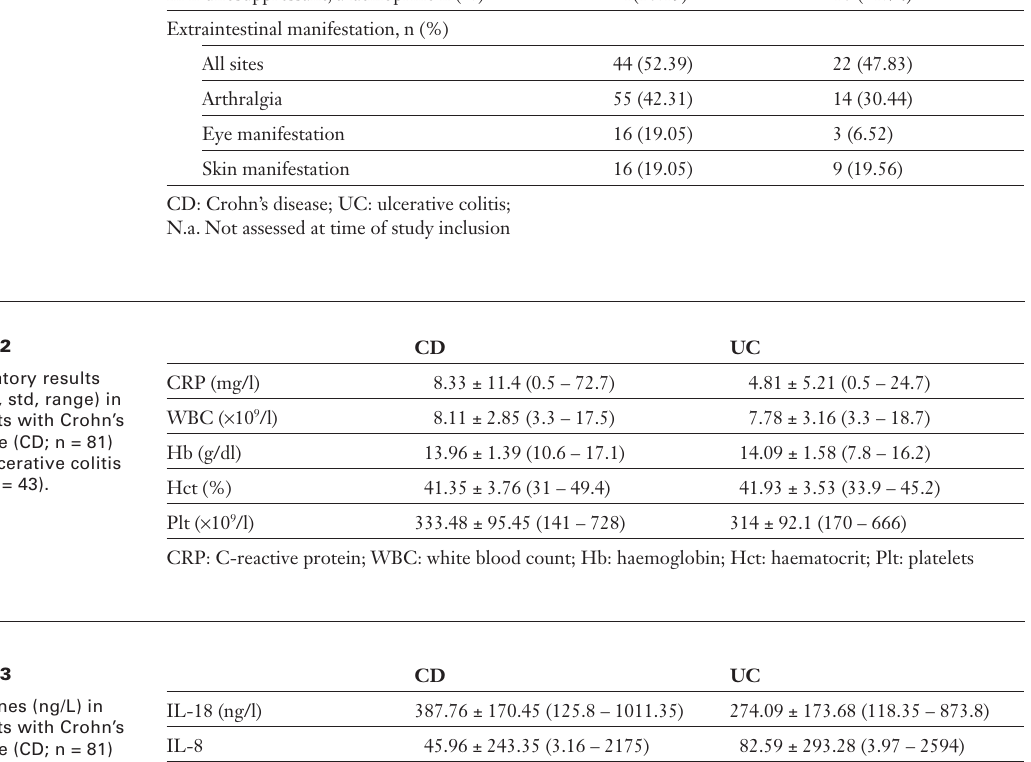
Cytokines (ng/L) in patients with Crohn’s disease (CD; n = 81) and ulcerative colitis (UC; n = 43) (mean, Std,